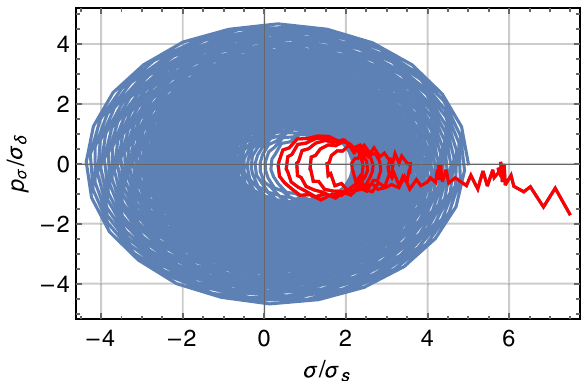
FIG. 9. Longitudinal phase trajectories from numerical solution of (28) and (29) with vertical action in the form (53) correspond- ing to initial condition y ¼ 58 σ . The last 200 turns are shown in y red. Compare with bottom right plot of Fig.